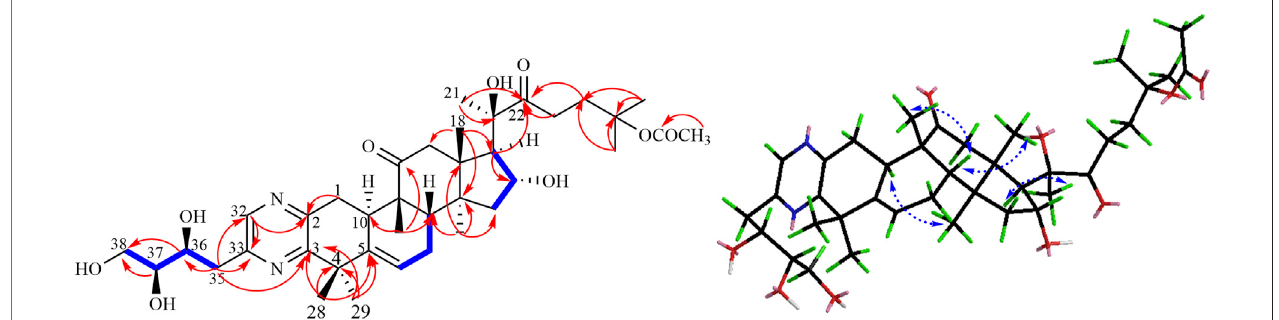
FIGURE 2 | Key 1 H- 1 H COZY, HMBC, and NOESY correlations of compound 1